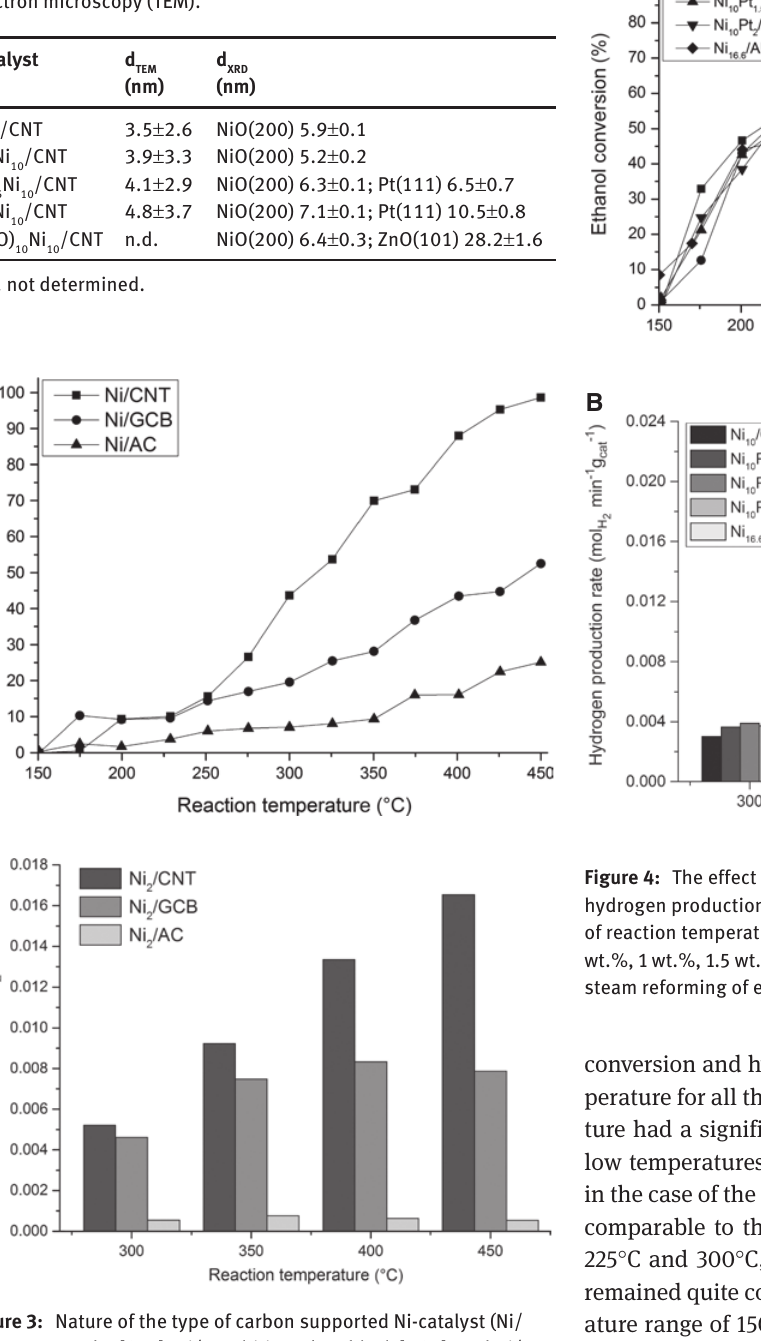
Figure 3: Nature of the type of carbon supported Ni-catalyst (Ni/ carbon nanotube [CNT], Ni/graphitic carbon black [GCB], and Ni/ activated carbon [AC]) in steam reforming of ethanol (SRE) on (A) ethanol conversion and (B) hydrogen production rate (in terms of -1 ) as a function of reaction temperature. mol min -1 g H 2 cat